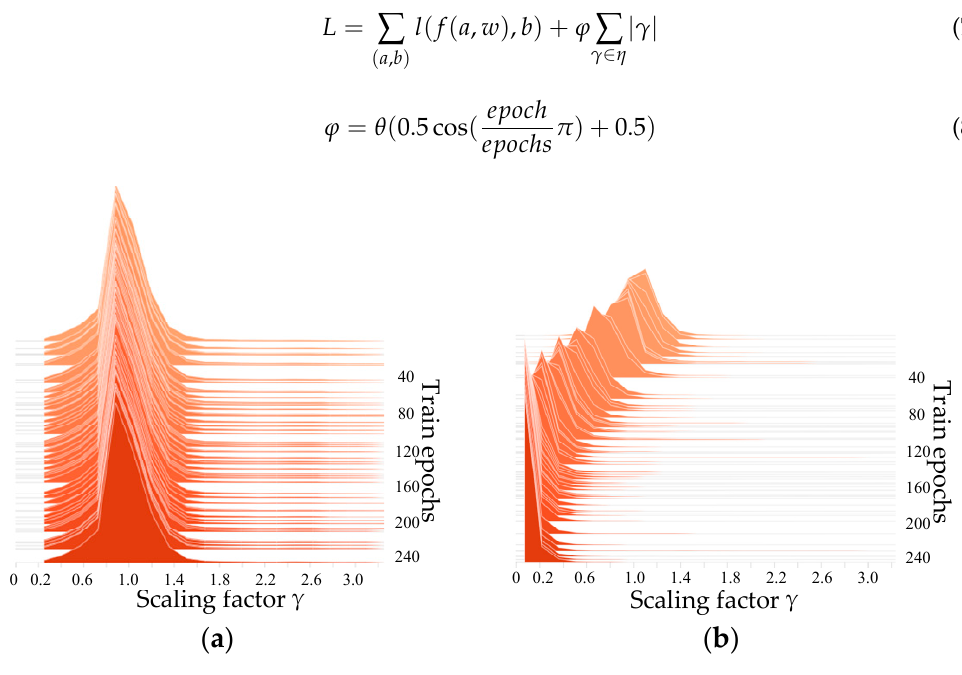
Figure 9. Histogram of scaling factor. ( a ) Normal training; ( b ) sparse training.